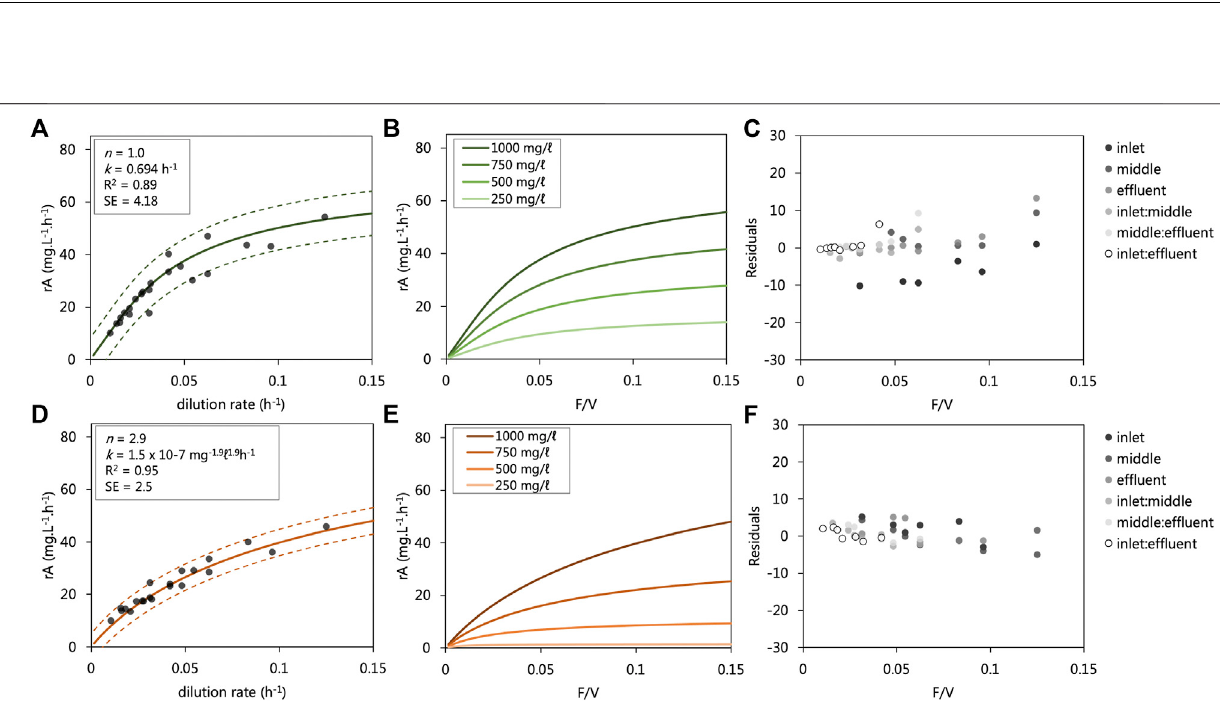
FIGURE5| Modelledsulfatereductionratesobservedinthe (A,B) lactate-and (D,E) acetate-supplementedUAPBRsatarangeof fl owratetovolumeratios(F/Vor dilution rates). The modelled reaction rates are shown over a range of applied dilution rates where the starting substrate concentration (C 0 ) is 1,000 mg/L (A,B) with observed reaction rate data from the inlet zones (0.33 L), composite inlet and middle zones (0.66 L) and entire reactors (1.0 L). The determined reaction order ( n ), rate constant ( k ), R 2 value and standard error (SE) calculated for each of the modelled datasets are shown. The residuals of the modelled minus observed sulfate reduction rates are shown for the (C) lactate and (F) Acetate UAPBRs. The relation between the observed and modelled reaction rates of the entire dataset is shown in Supplementary Figures S2,S3 . C; (D) Modelled reaction rate data at various fl ow rate to volume ratios (F/V) with various starting sulfate starting concentrations (C 0 ) is shown. 95% con fi dence intervals are shown as dashed